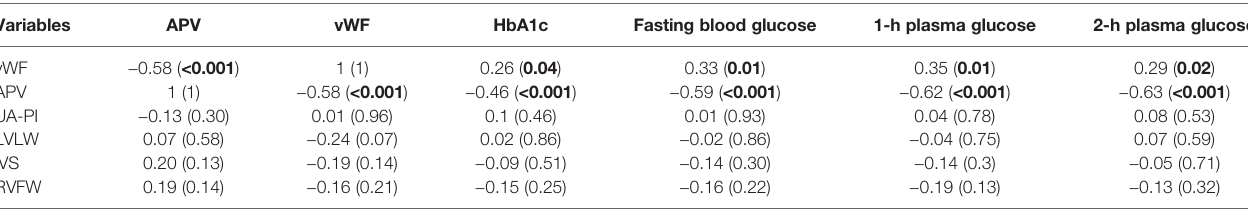
TABLE 3 | Correlation between ultrasonic measurements with vWF as well as HbA1c and glucose. Variables APV vWF HbA1c Fasting blood glucose 1-h plasma glucose 2-h plasma